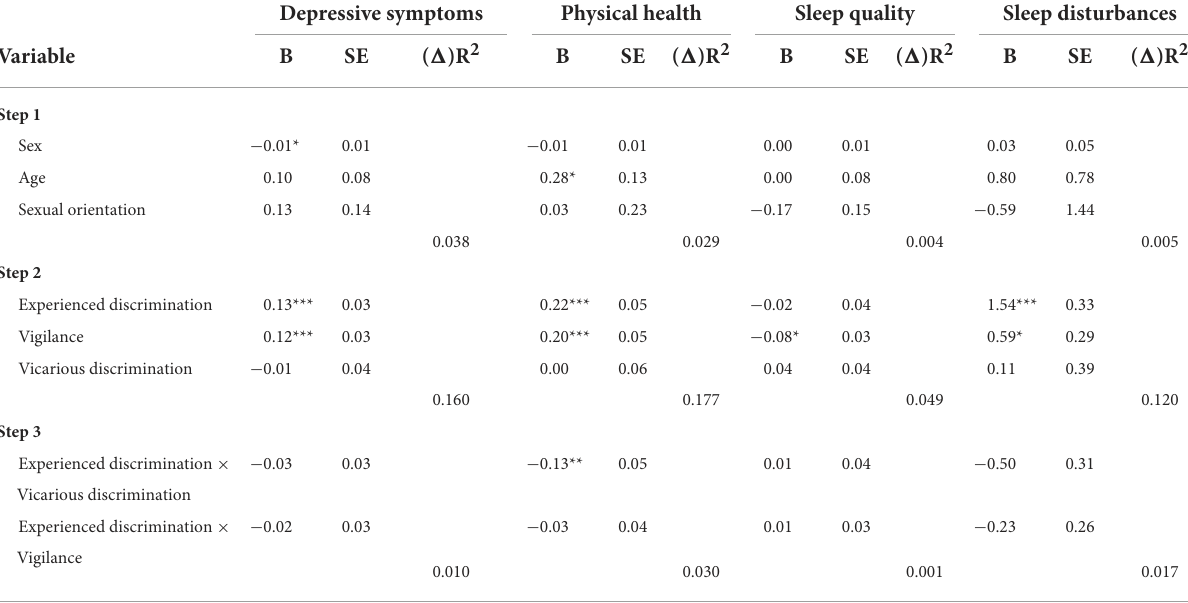
TABLE 2 Experienced discrimination, vigilance, and vicarious discrimination predicting health and wellbeing outcomes. Depressive symptoms Physical health Sleep quality Sleep